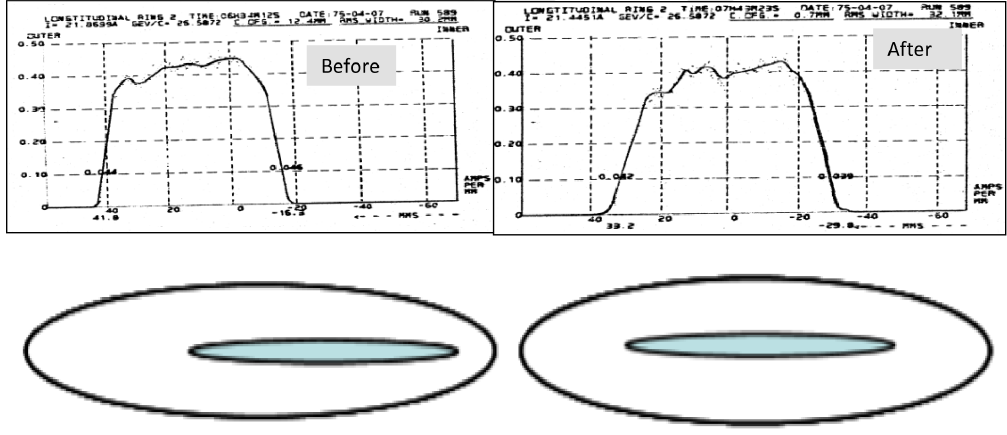
FIG. 10. Stack centering: before (left) and after (right).